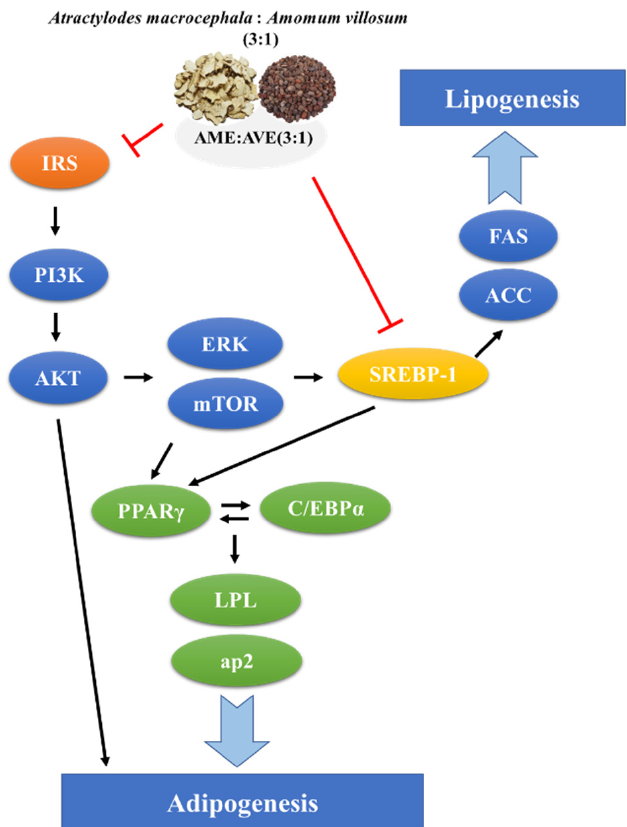
Figure 8. The proposed anti-obesity effects mechanism of Atractylodes macrocephala and Amomum villosum extracts (3:1).